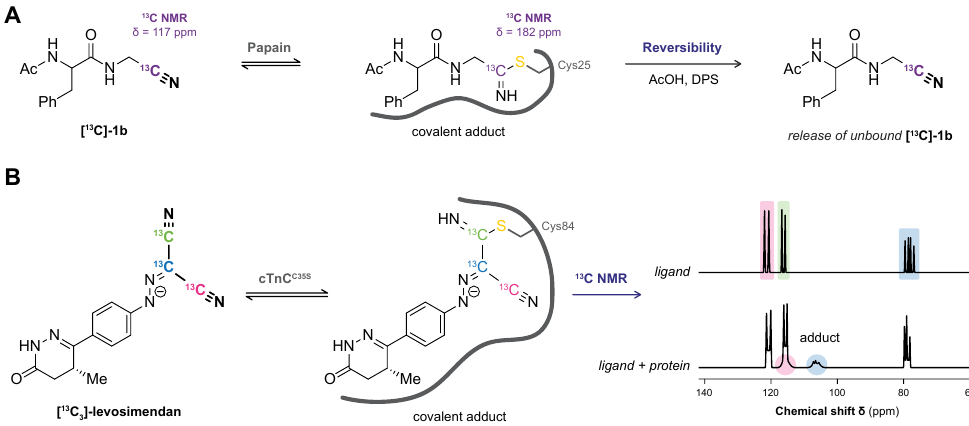
Figure 8. Ligand-observed 13 C NMR detection of covalent protein–drug adducts. ( A ) Chemical shift perturbation of the electrophilic 13 C-labeled carbon in unbound nitrile [ 13 C]- 1b relative to the thioimidate ester adduct provides evidence of a covalent papain–nitrile adduct [172]. Detection of unbound nitrile upon treatment with glacial acid (AcOH) and thiol-trapping reagent 2,2 (cid:48) -Dipyridyldisulfide (DPS) is indicative of a reversible covalent binding mode. ( B ) Ligand-observed NMR studies with 13 C-labeled levosimendan provide evidence for reversible covalent binding to a cysteine thiol in cardiac troponin C (cTnC)